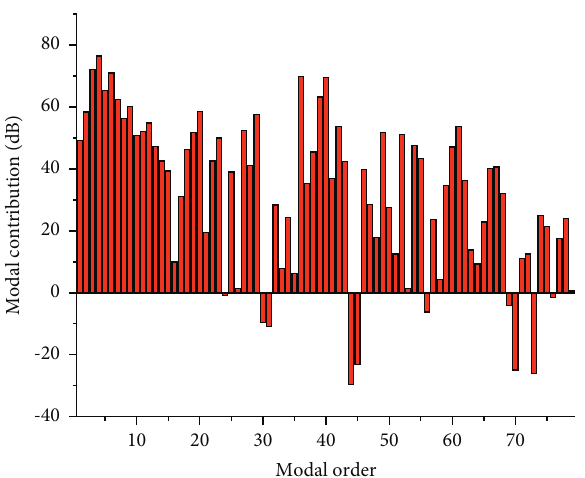
Figure 13: Modal contribution of the cab at 50